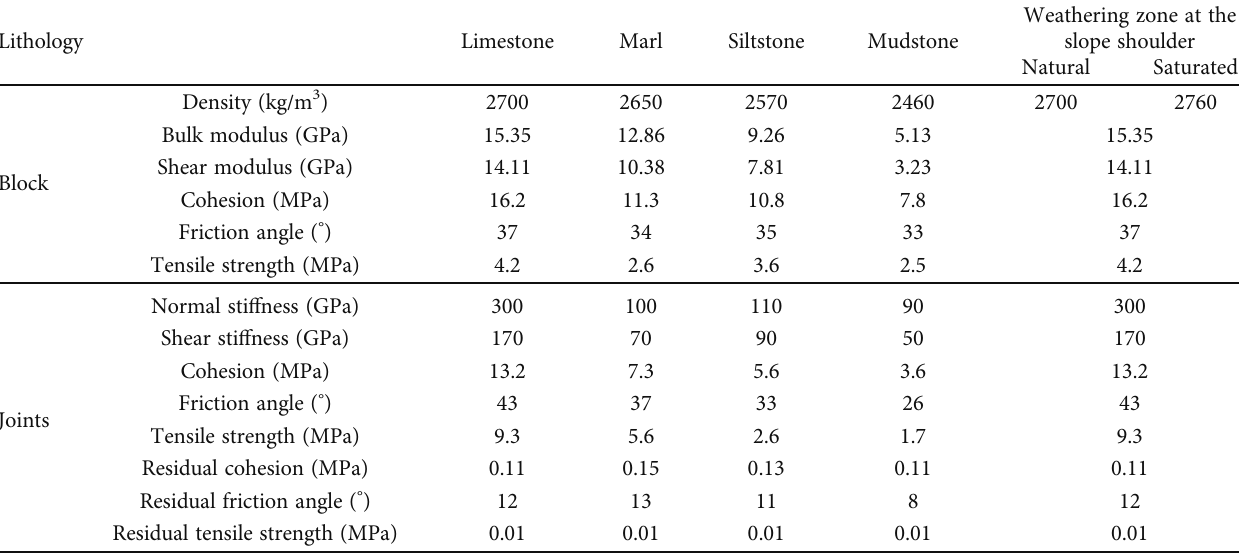
Figure 6: Model geometry and boundary conditions. Table 1: Parameters of rock masses with the Voronoi grid.